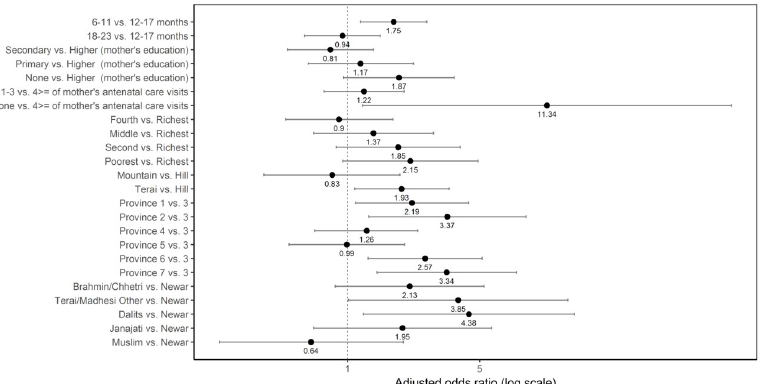
Fig 13. Odds ratio plot with 95% confidence intervals for not consuming eggs among Nepalese children aged 6 to 23 months.